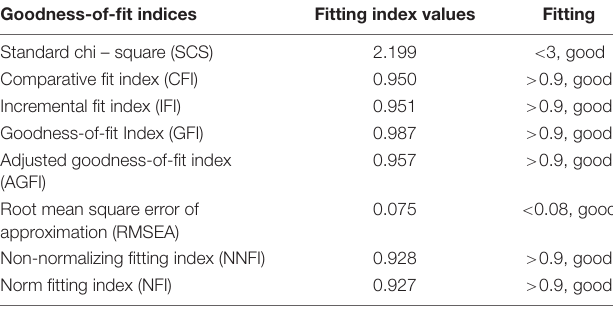
TABLE 5 | Structural equation modeling fitting.